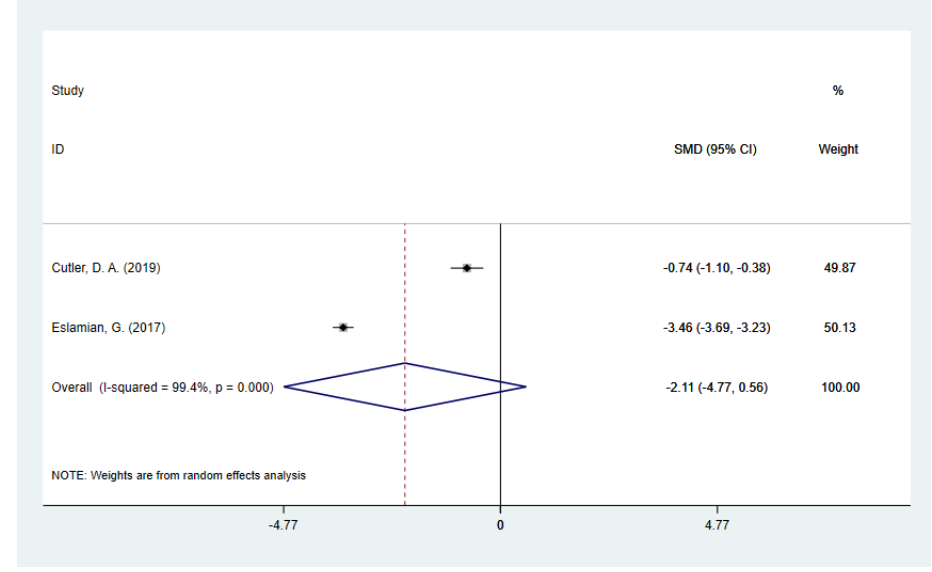
Figure 4. Meta-analysis of daily dietary fiber intake on studies adjusted for total energy intake [41,49].